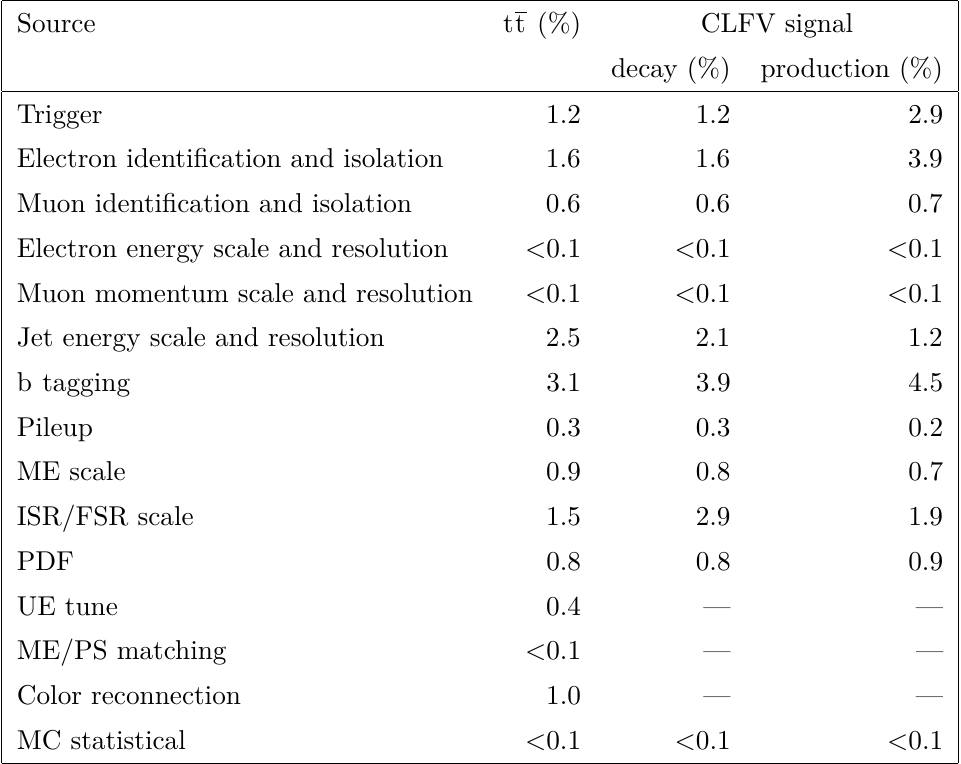
Table 3 . Summary of representative systematic uncertainties in selection efficiency for the SM tt process and for single top quark production and decays via vector e m tu CLFV interactions in the signal plus tt control